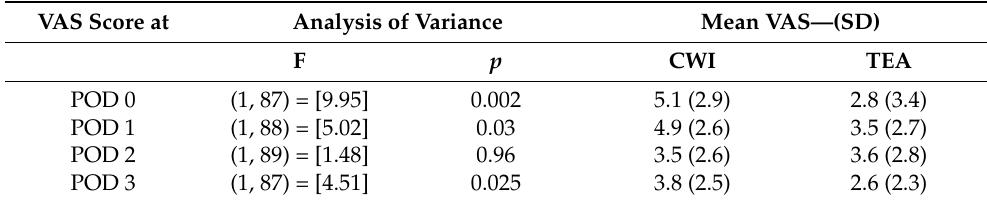
Table 2. Analysis of variance (one-way ANOVA) and mean visual analogue scale (VAS) for pain score reported by CWI and TEA patients on each postoperative day (POD). VAS Score